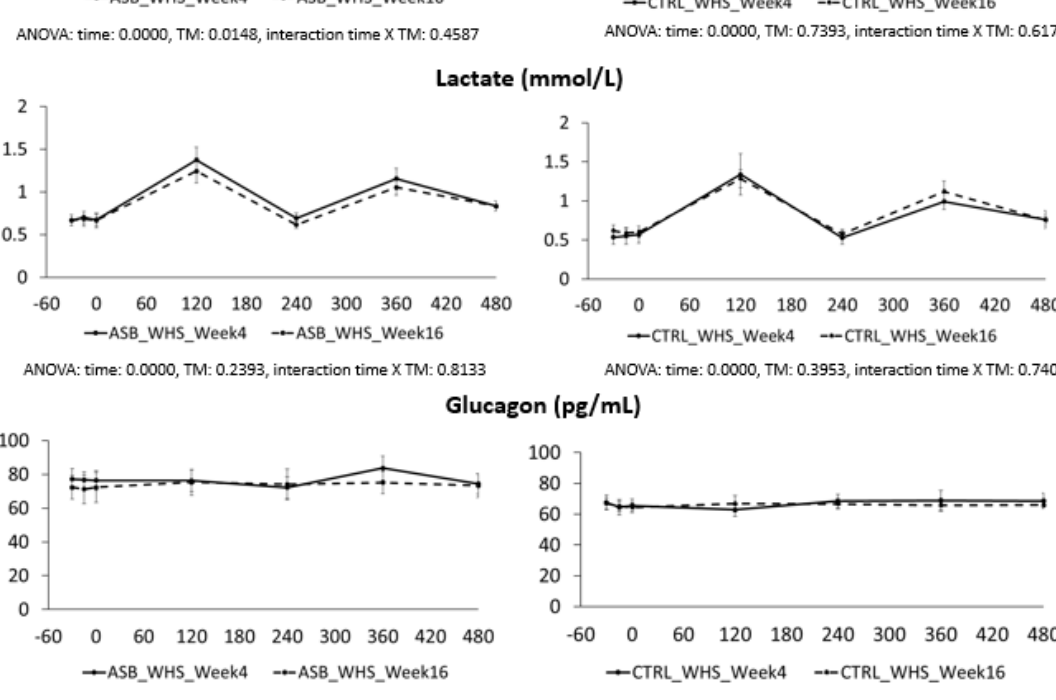
Figure 3. Plasma concentrations of glucose, insulin, lactate and glucagon in participants without hepatic steatosis. Data are expressed as mean ± SEM.; solid lines correspond to week 4, dotted lines to week 16. Results for ASB arm are shown on the left part, and for CTRL arm on the right part of the graph. Statistics (two-way ANOVA for repeated measurements with interaction) are reported at the bottom of each graph.